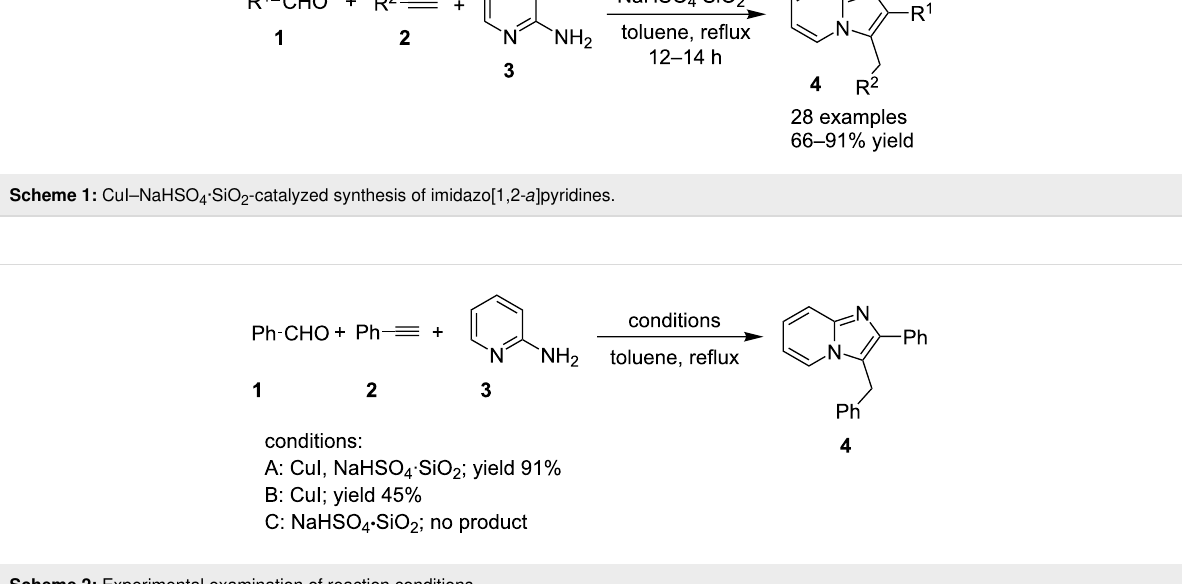
Scheme 2: Experimental examination of reaction